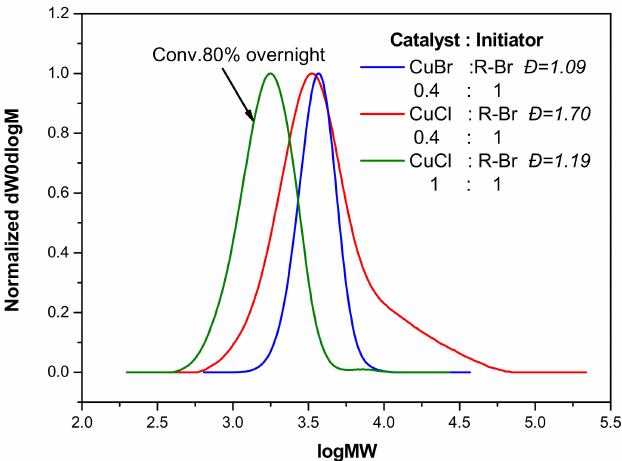
Figure 7. DMF SEC molecular weight distributions for PNIPAM via Cu(0)-mediated polymerization in H 2 O at 0.0 ◦ C (blue trace) [bromo-initiator]:[CuBr]:[Me 6 TREN] = 1:0.4:0.4. and (red trace) [bromo- initiator]:[CuCl]:[Me 6 TREN] = 1:0.4:0.4. (green trace) [bromo-initiator]:[CuCl]:[Me 6 TREN] = 1:1:1.